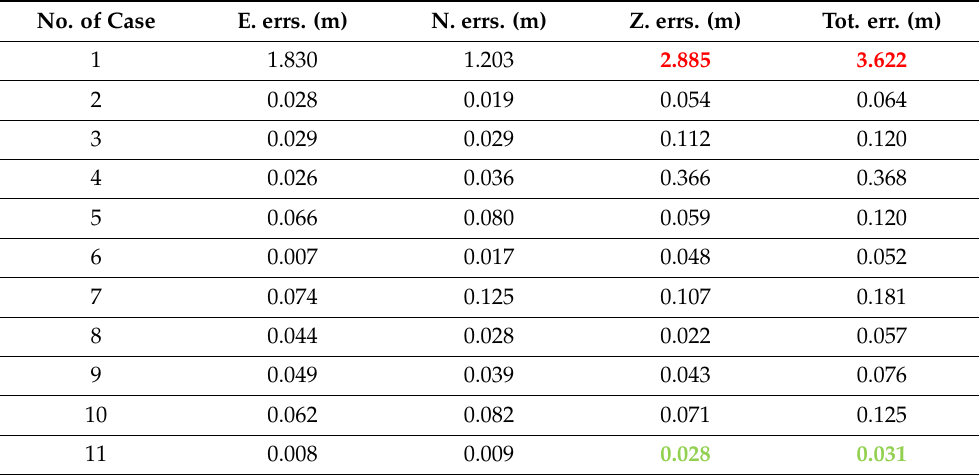
Table 3. The positional accuracies of the eleven cases. [ red color for maximum error, green color for minimum error]. No. of Case E. errs. (m)